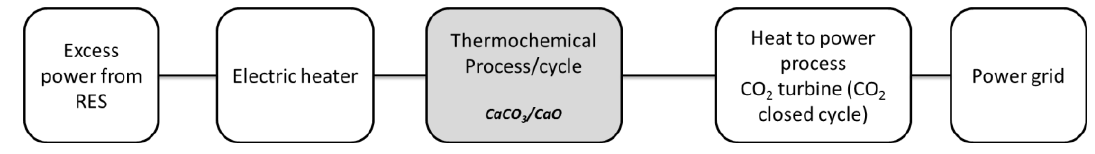
Figure 9. PtH/TCTES system developed by Fernandez et al. [236]. Figure 9. PtH / TCTES system developed by Fernandez et al. [235].